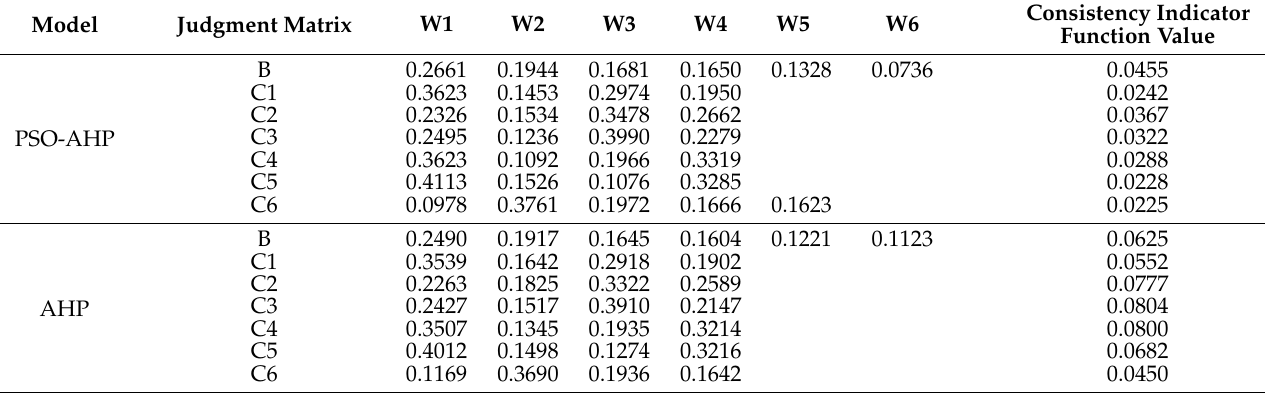
Table 3. Comparison table of PSO-AHP and AHP judgment matrix calculation